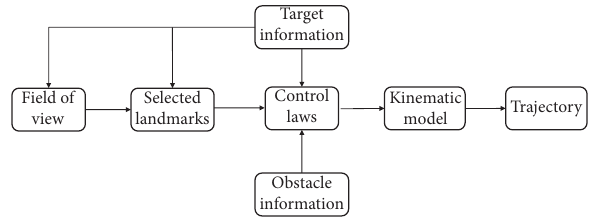
Figure 1: Block diagram illustrating the control